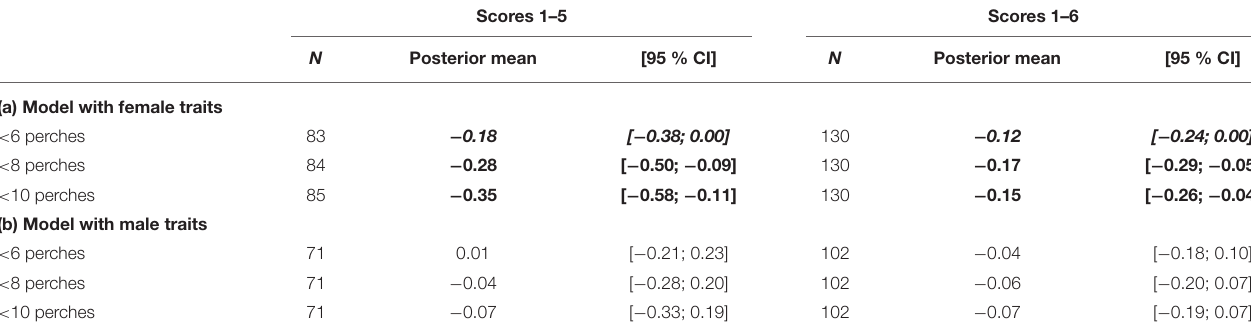
TABLE 3 | Summary of the estimates for the learning score effect on the probability to copy tit preference, when alone (i.e., no interaction with age included in the model) depending on the value considered for defining the learning threshold ( < 6, 8, or 10 perches per entrance, for two successive entrances) and the individuals considered (individuals with scores 1–5 only or individuals with scores 1–6), for (a) females and (b)